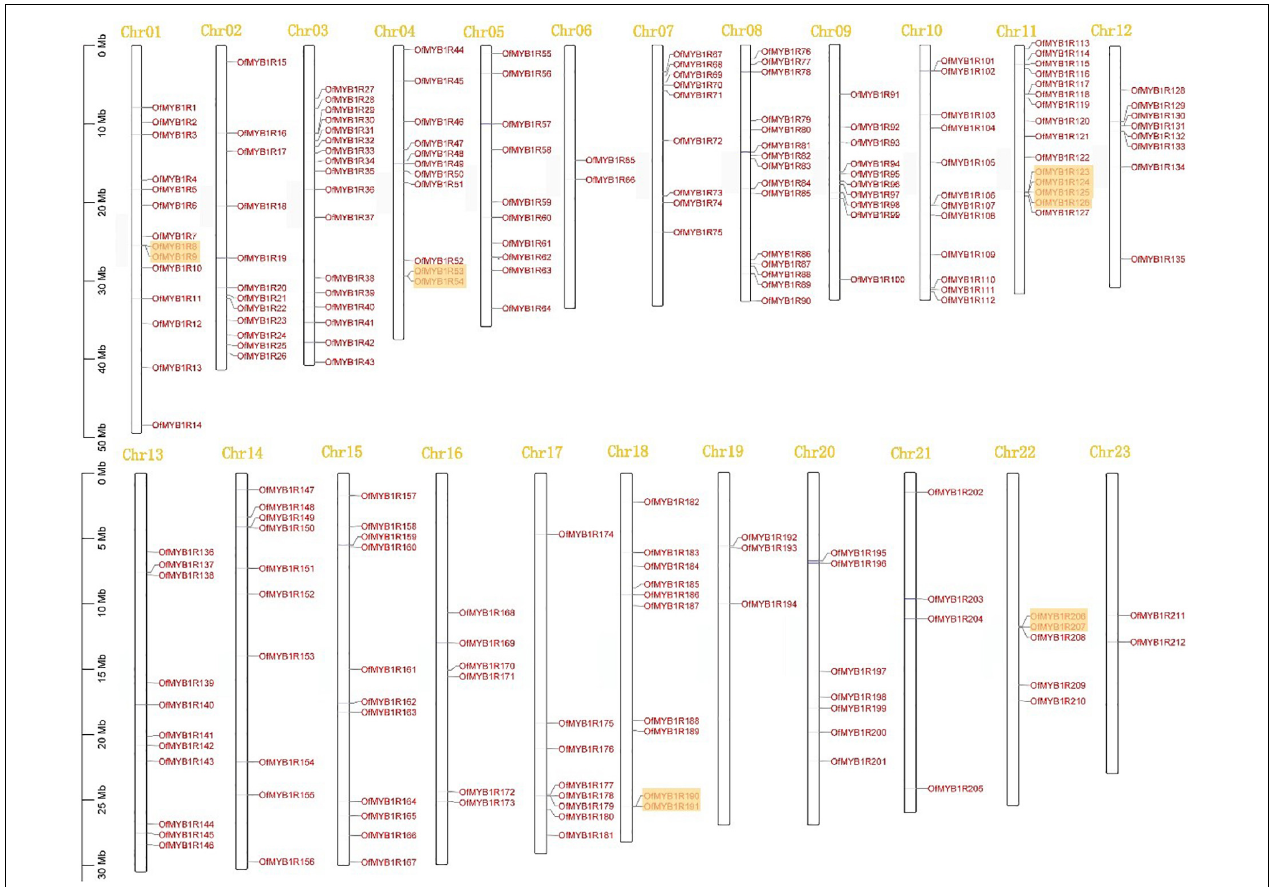
FIGURE 3 | Chromosomal locations of 212 OfMYB-related genes, mapped on the basis of the GFF files of O. fragrans . The numbers at the top represent each chromosome. Orange boxes represent clusters of tandemly duplicated